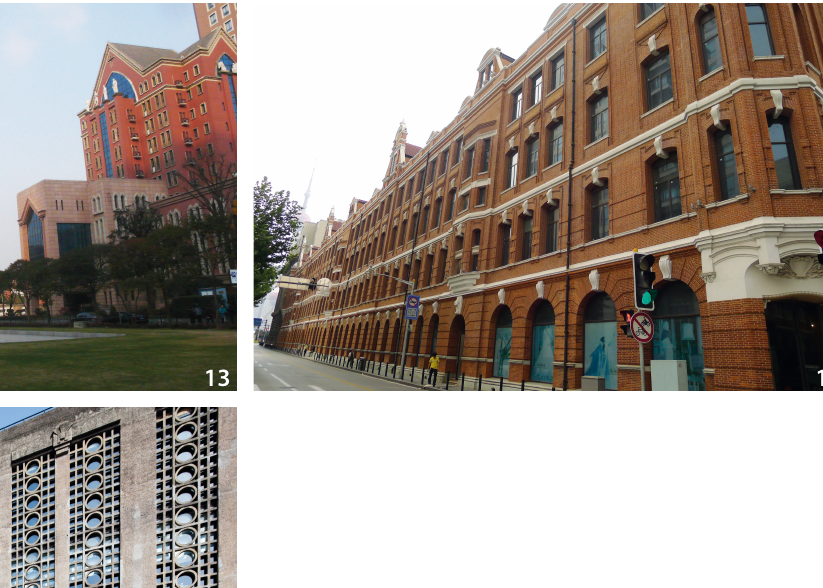
Figure 13 The high–rise buildings around St. Ignatius Cathedral at Xujiahui, Shanghai (Source: Institute of Shanghai Architectural Design and Research Co., Ltd). Figure 14 The former Abraham, E. Building after restoration and renovation (Source: Institute of Shanghai Architectural Design and Research Co., Ltd). Figure 15 The former Abattoir after renovation (Source: the